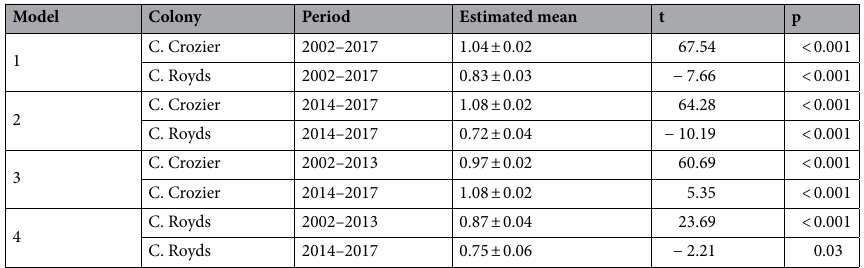
Table 2. Differences in reproductive success between colonies, Cape Crozier and Cape Royds, Ross Island, Antarctica, and time periods estimated with a generalized least squares model accounting for autocorrelation and repeated measures at subcolonies. Models 3 and 4 are comparing differences between the study period (2014–2017) and the longer-term mean at the same colony.